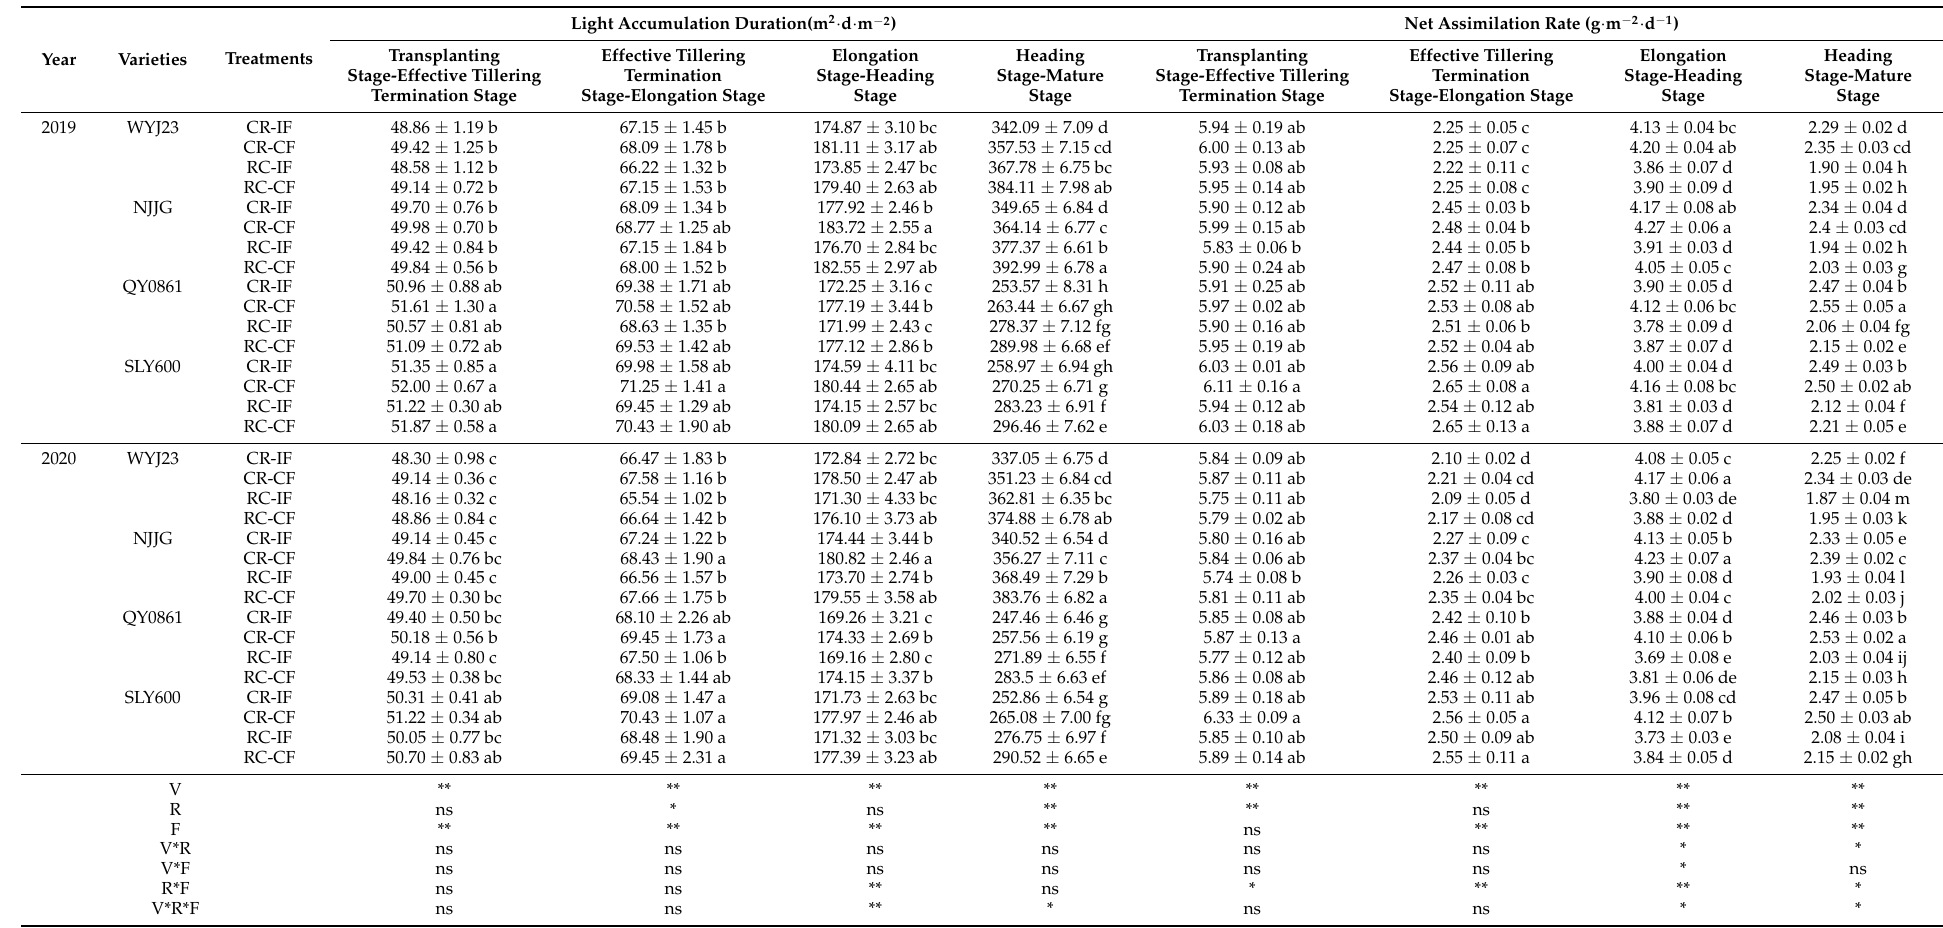
Table 3. Light accumulation duration and net assimilation rate of different rice varieties under two types of fertilizer